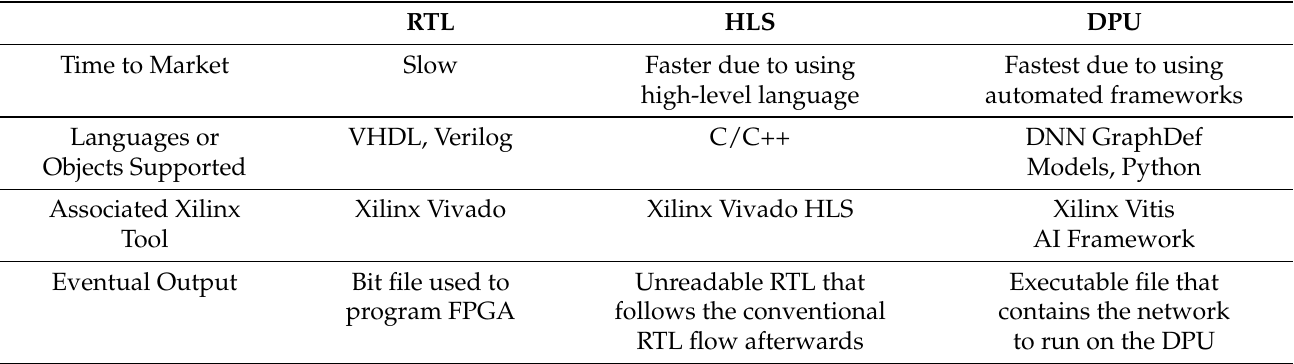
Table 3. Comparison between Different Accelerator Development Flows [26–28].